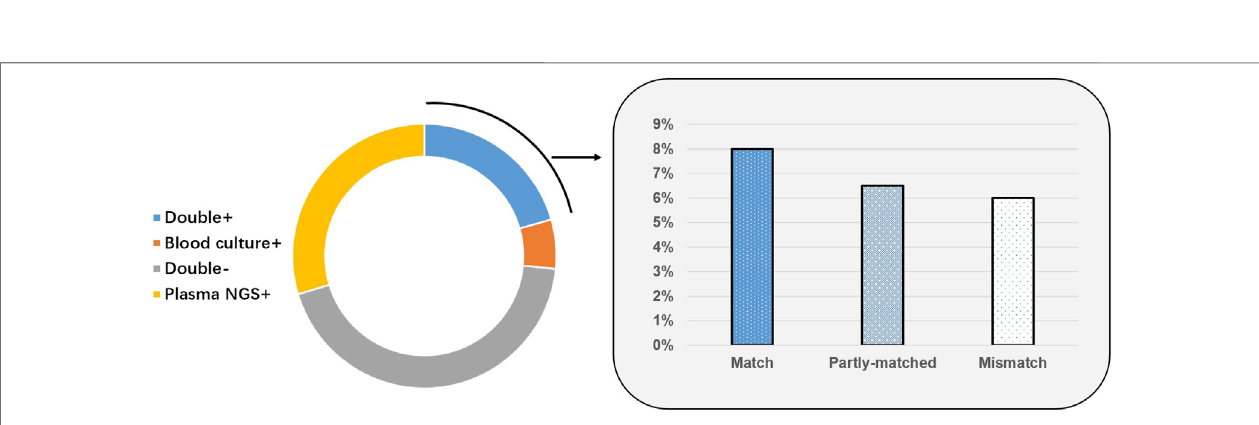
FIGURE 4 | Correlation and concordance between plasma microbial cell-free DNA (mcfDNA) sequencing and blood culture for all samples ( n (cid:1) 199).